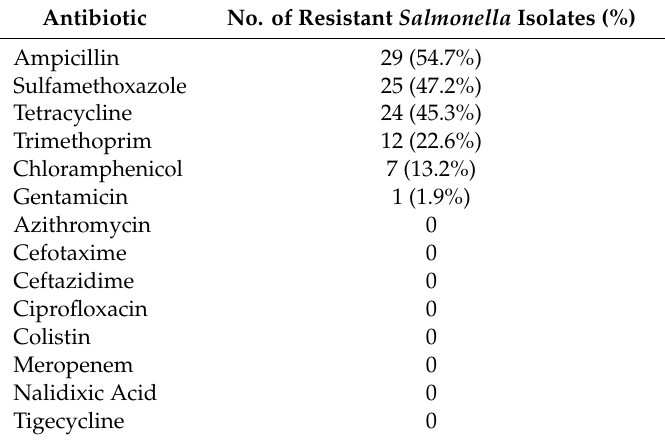
Table 2. Number of Salmonella isolates resistant to the antibiotics tested in the Sensititre EU Surveillance Salmonella / E. coli (EUVSEC)